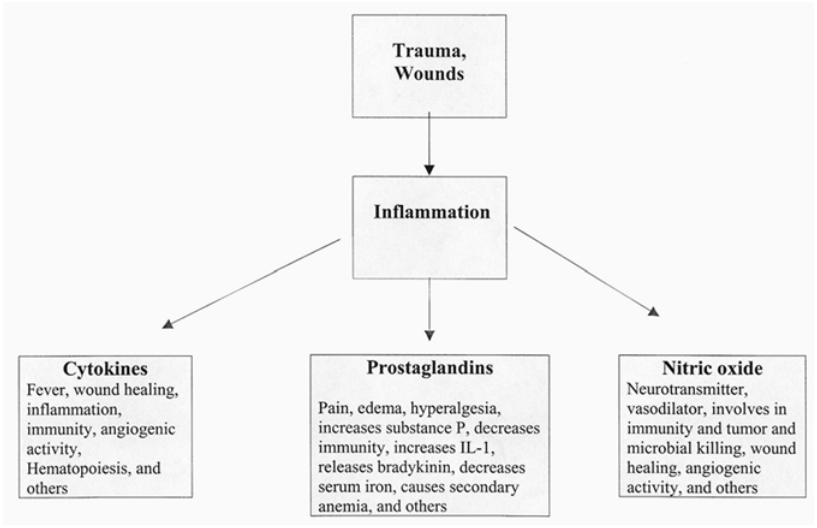
FIGURE 1. Mediators of biological response to